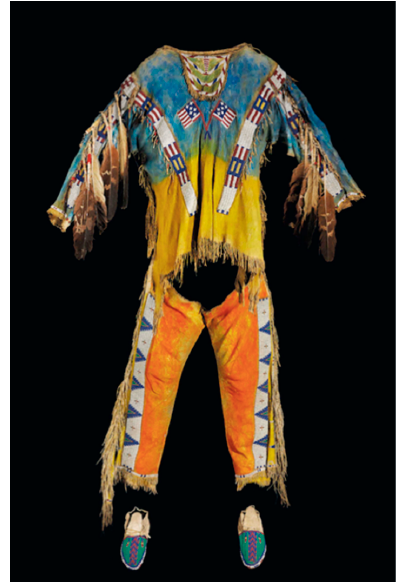
Figure 1. Plains Indian buckskin tunic and leggings, c. 1880s, beadwork, eagle feathers, paint, and quillwork on deerskin. Mus é e de l’Atelier Rosa-Bonheur, Ch â teau de By, Thomery, France. Photograph